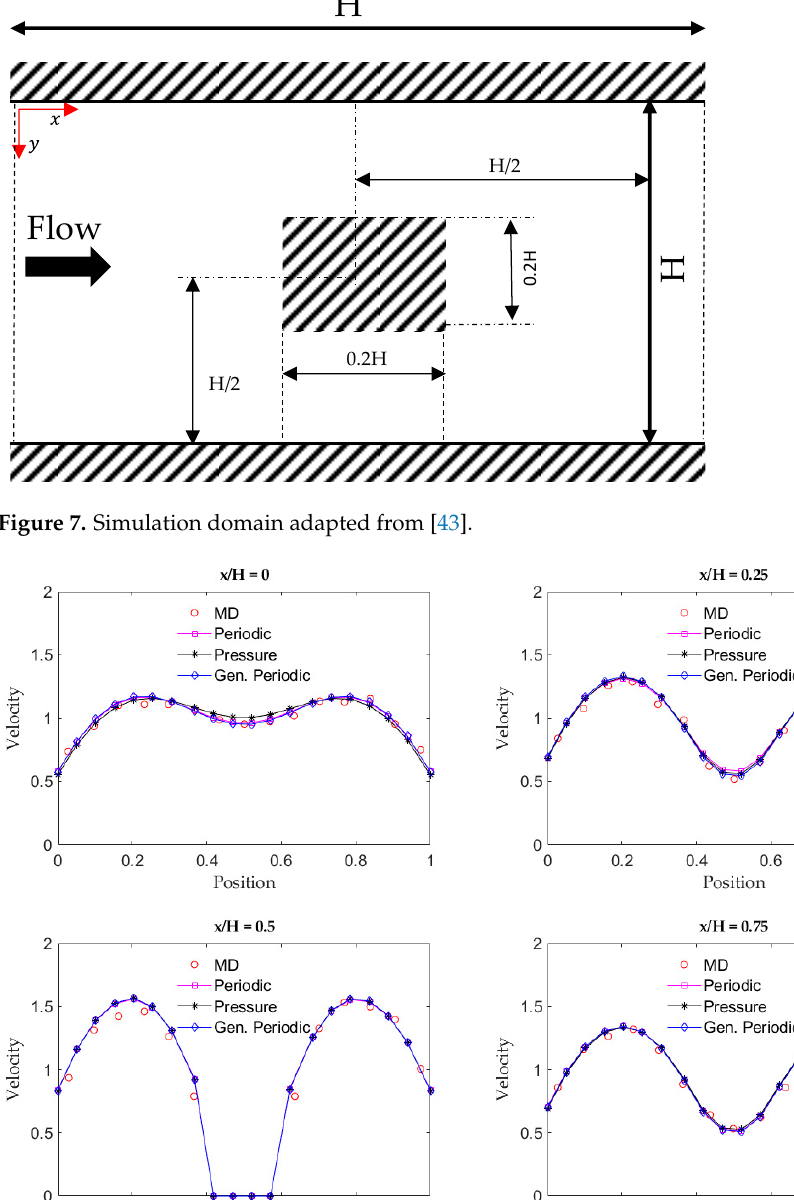
Figure 9. Benchmark domain adapted from [42] . H H/3